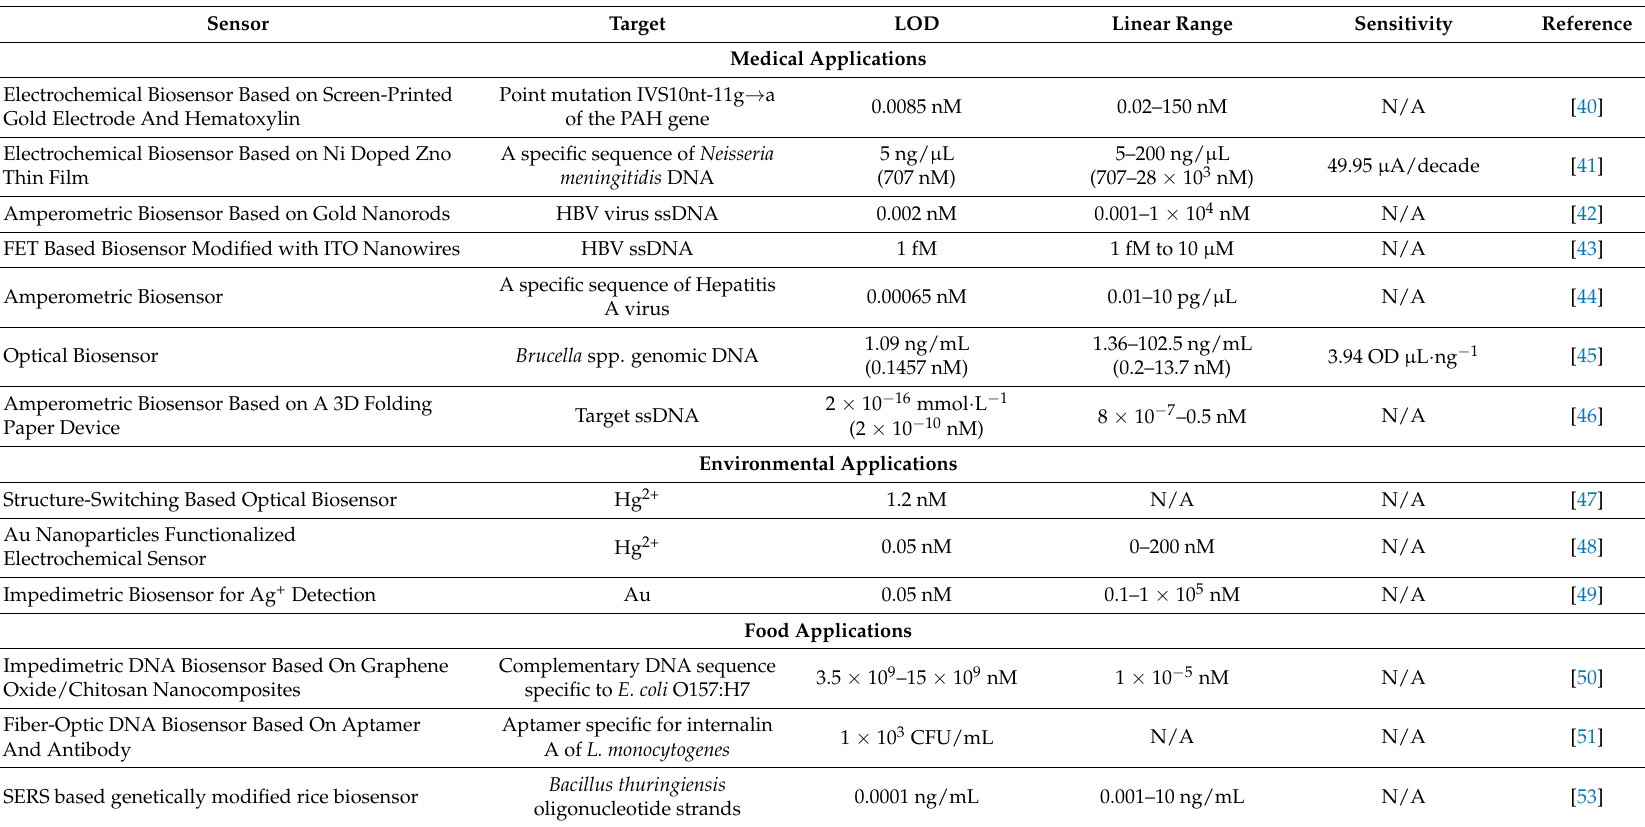
Table 3. Analytical performances of recent publications on DNA-based